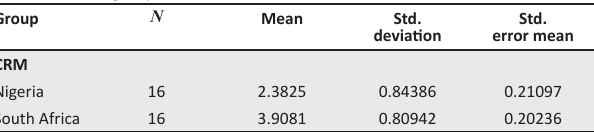
TABLE 2: T -test group